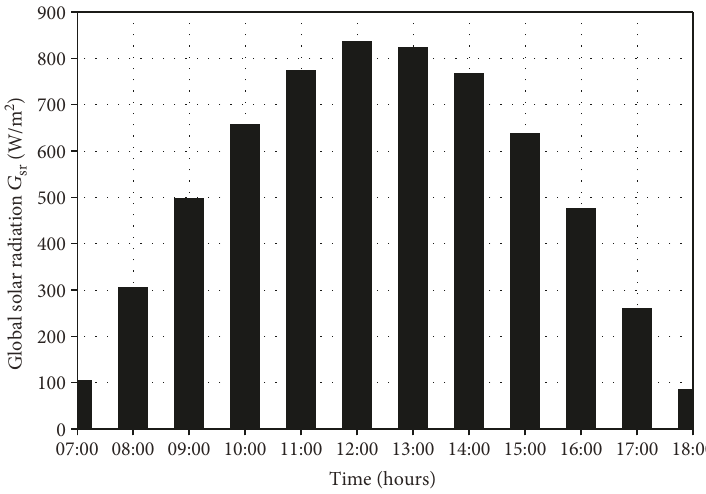
Figure 4: Yearly hourly average values of global solar